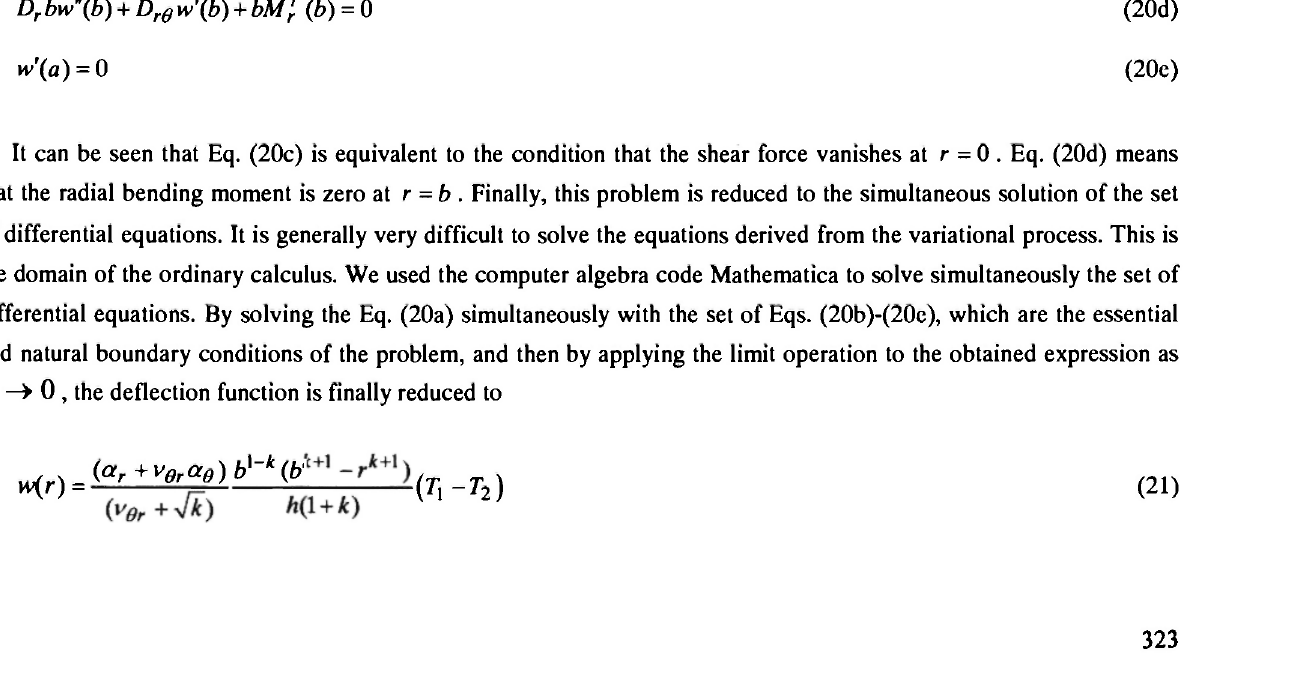
Fig. 2: Model of an aircraft